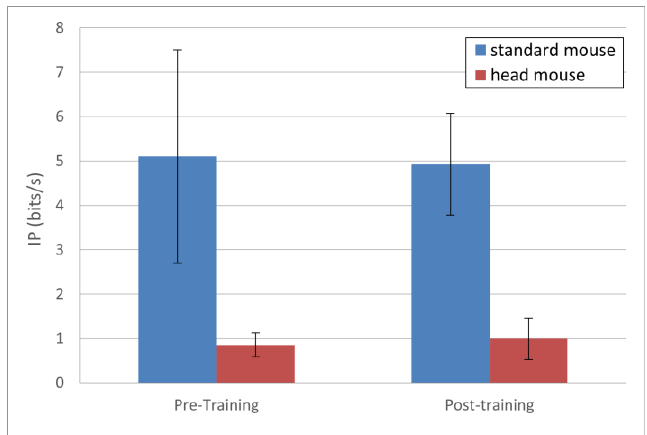
Figure 4. MT mean values and standard deviations. No statistically significant changes comparing pre- and post-training ( p > 0.1 for both the standard mouse and the head mouse).